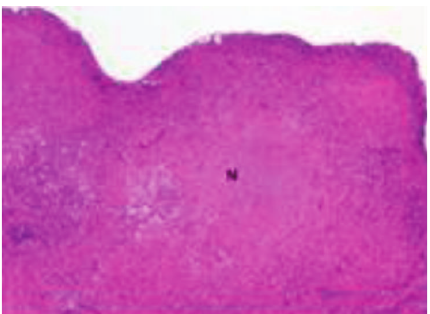
Figure 2: Mesenteric lymph node biopsy demonstrating granulo- mas with areas of caseous necrosis (N) (H&E stain, 10x magnifica-